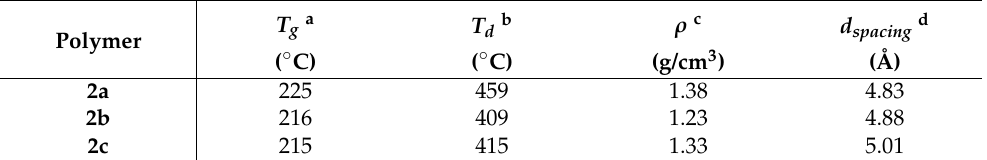
Table 1. Physical parameters of the thiol ‐ functionalized polymers.